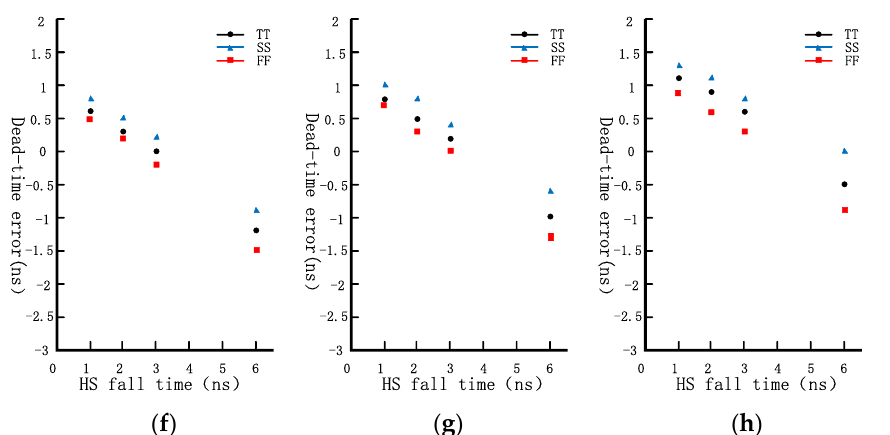
Figure 11. ( a ) High-side dead-time control circuit VHO simulation ( b ) Low-side dead-time control circuit VLO simulation ( c ) High-side dead-time control signal VHO error in -55 °C ( d ) High-side dead-time control signal VHO error in 25 °C ( e ) High-side dead-time control signal VHO error in 125 °C ( f ) Low-side dead-time control signal VLO error in -55 °C ( g ) Low-side dead-time control signal VLO error at 25 °C ( h ) Low-side dead-time control signal VLO error at 125 °C. is divided into 90 V/ns, 45 V/ns, 30 V/ns, and 15 V/ns) dead-time error is within 5 ns.